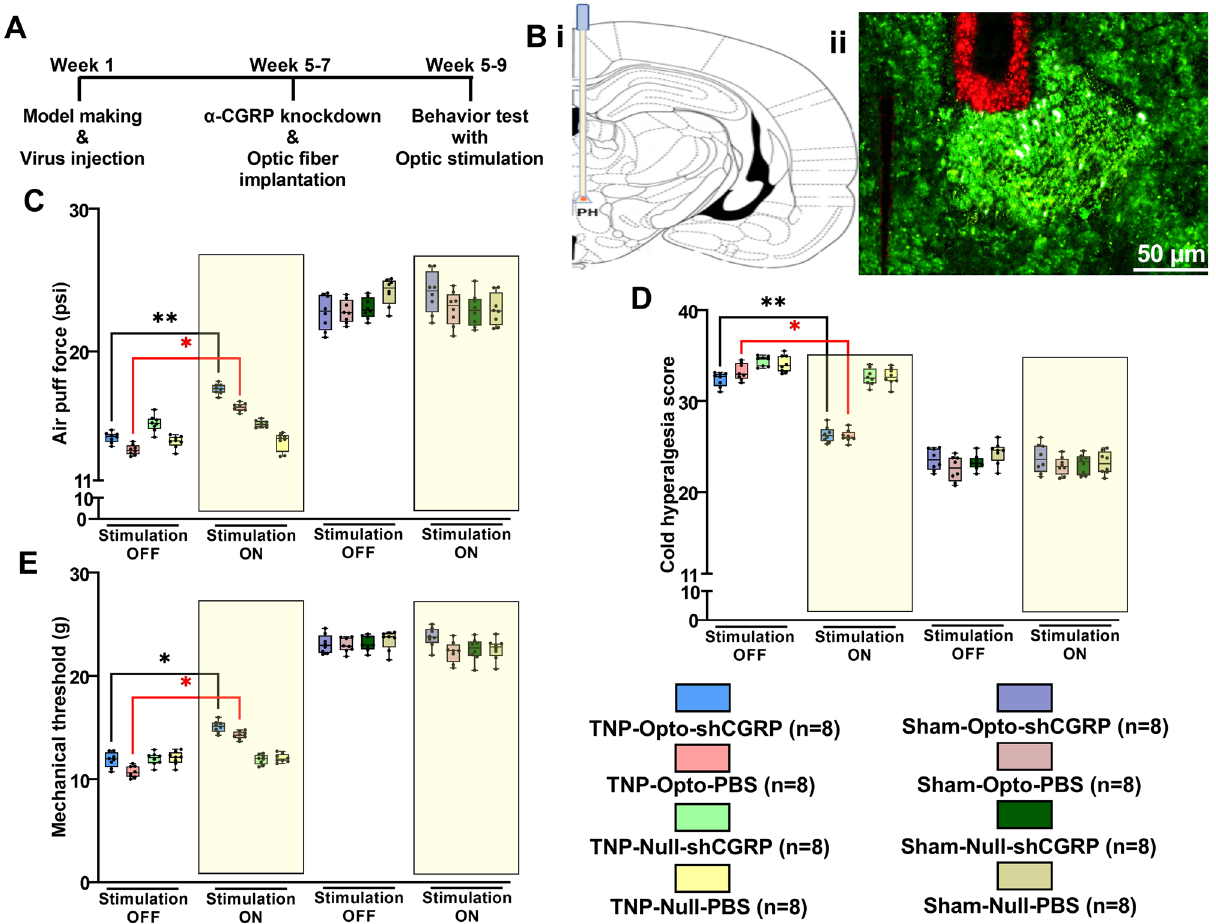
Figure 5. Optogenetic inhibition of PH improved TNP pain behavioral responses. ( A ) Timeline of optogenetic virus injection, optic fiber implantation and behavior tests. ( B ) Schematic diagram showing the location of the PH (i) and representative images of the optic fiber implantation location in the PH (ii). Positive expression of NpHR-EYFP was observed in the PH (green) and GFAP immunostaining (red) illustrated the optic fiber tract to the PH. Scale bar: 50 µm. ( C – E ) Changes in behavioral responses following yellow laser stimulation. The results from the air-puff test ( C ), cold allodynia score test ( D ), and von Frey test ( E ). The TNP-Opto groups exhibited significant changes in behavioral scores during the stimulation “ON” condition. No significant changes in behavioral scores were observed in other animal groups during the stimulation “ON” condition. *, p < 0.05; **, p < 0.01, significant differences determined using paired t -test. Data are displayed as means ±